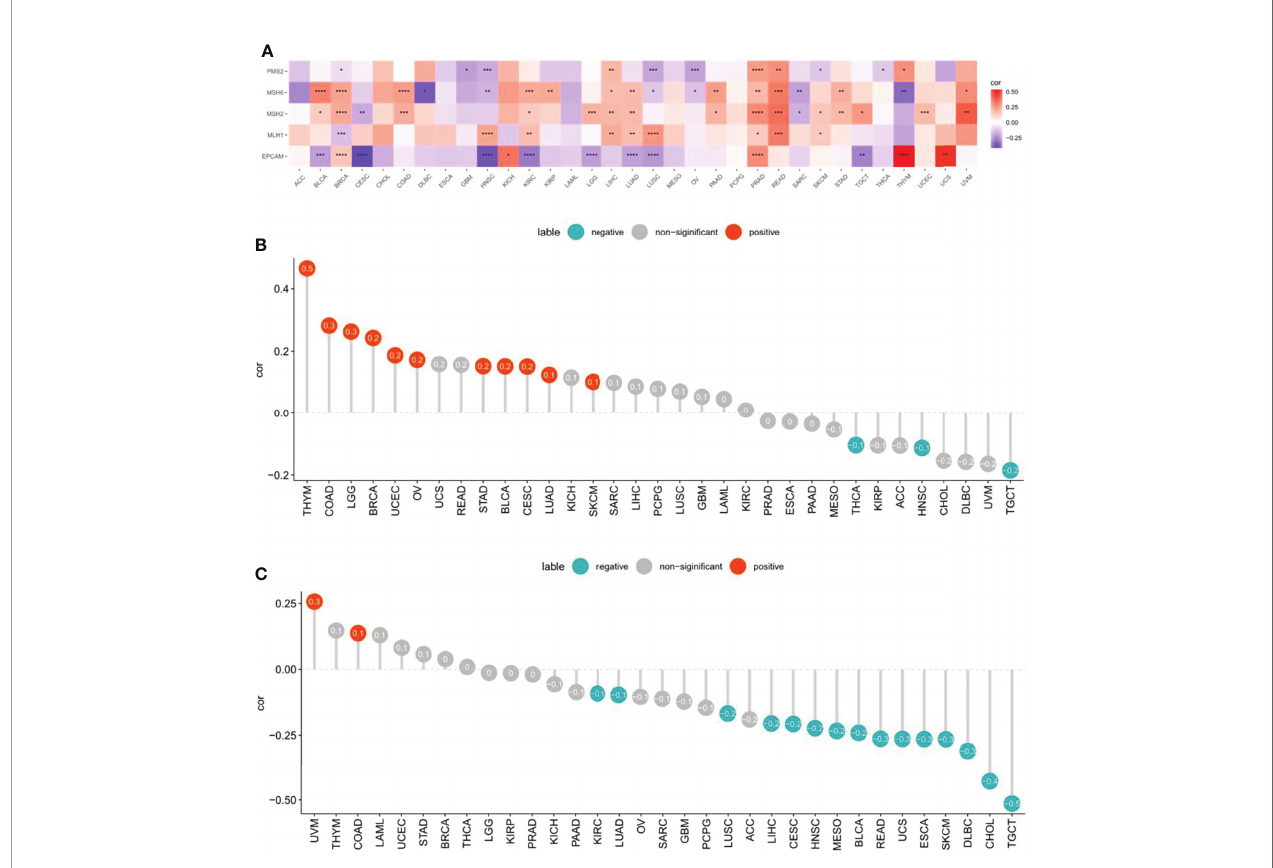
FIGURE 8 | Associations between CXCL11 expression and mismatch repair (MMR), tumor mutational burden (TMB), and microsatellite instability (MSI) across cancers. (A) Association between CXCL11 expression and MMR genes in pan-cancer by heatmap. *p < 0.05, **p < 0.01, ***p < 0.001, and ****p < 0.0001 (B) Association between CXCL11 expression and TMB across cancers. (C) Association between CXCL11 expression and MSI across